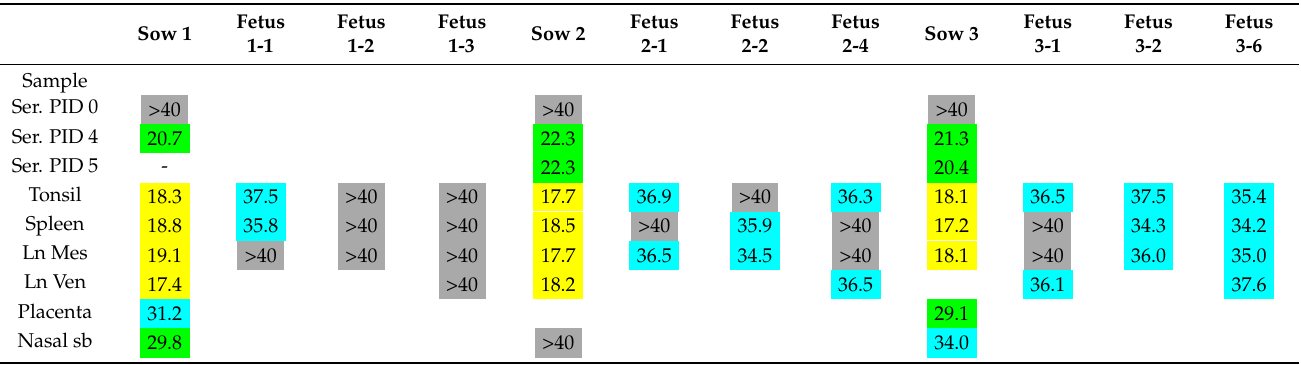
Table 1. Presence of ASFV DNA in samples from ASFV-infected sows and three of their fetuses collected during